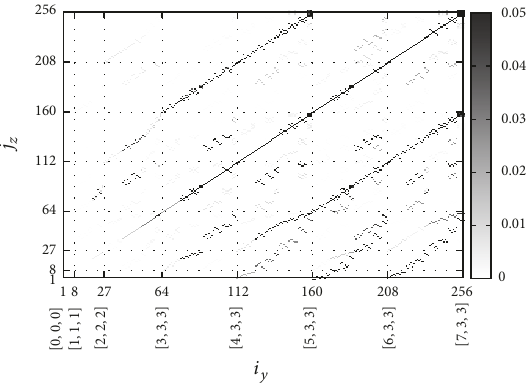
Figure 10: Cuboid modes (7th order, 𝑁 = 3 ).